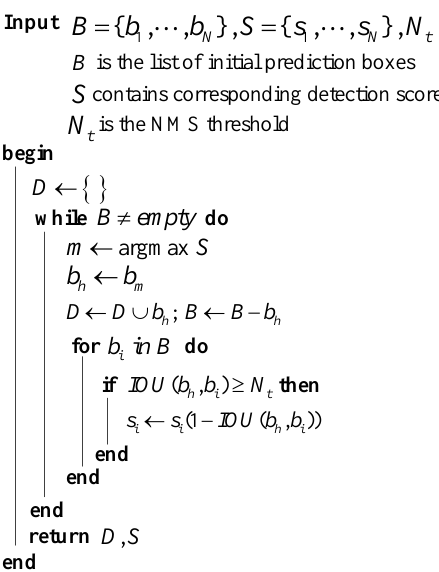
Figure 11. The implementation of the soft NMS algorithm.